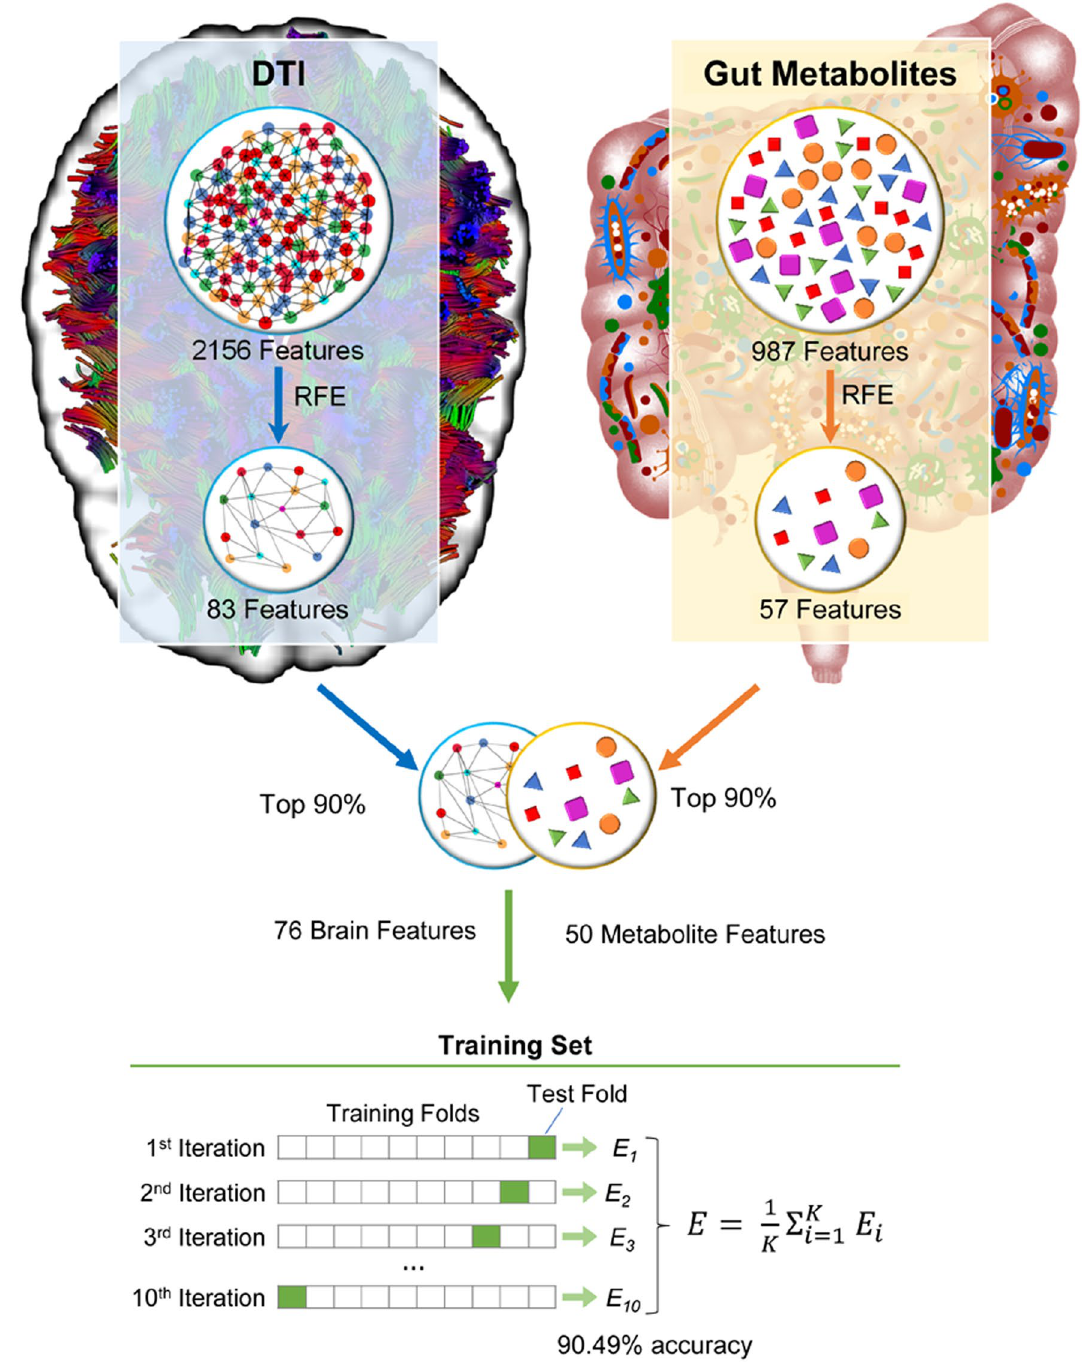
Figure 1. Study overview. In this study, we distil over three thousand unique brain microstructural and gut metabolite data into 76 brain and 50 metabolite features. These features were then used to create a machine learning model that could predict if patients were overweight or obese with over 90%